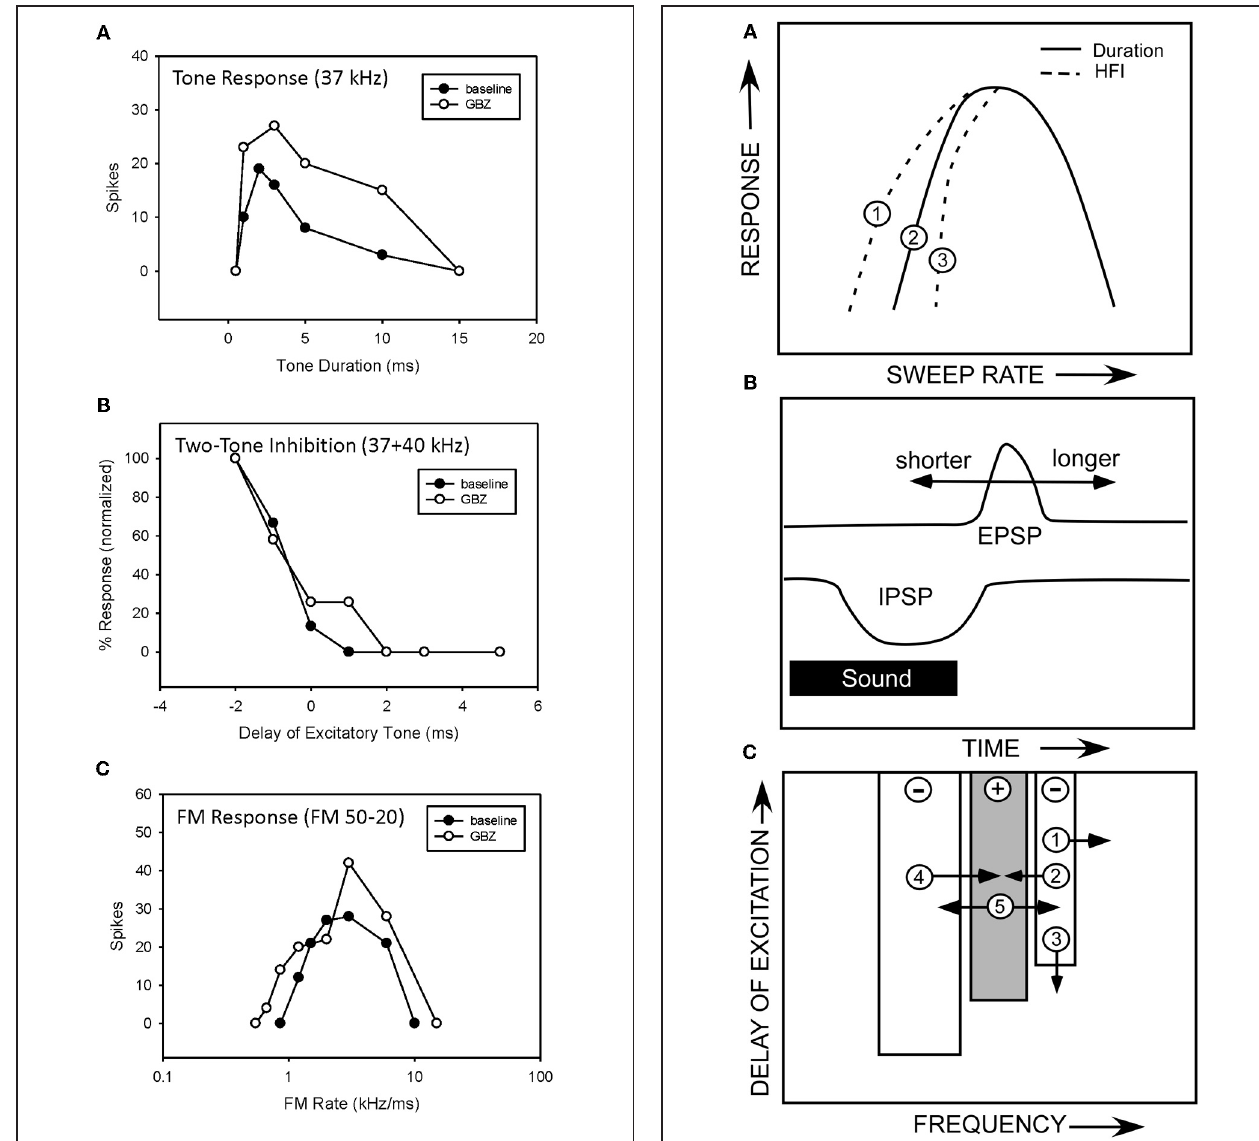
FIGURE 10 | (A) A hypothetical neuron showing how duration tuning and HFI could potentially affect sweep rate selectivity. (B) The anti-coincidence mechanism thought to underlie bandpass duration tuning. (C) A diagram of the multiple ways that changes in the properties of a neuron’s inhibitory and excitatory frequency domains could influence sweep rate selectivity. See